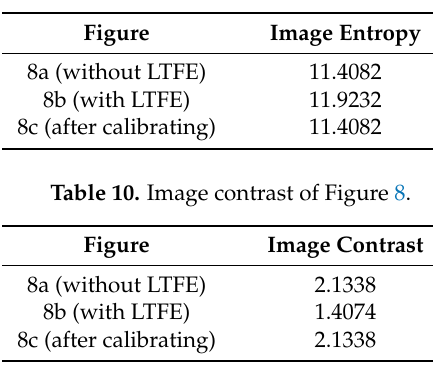
Table 9. Image entropy of Figure 8. Figure Image Entropy